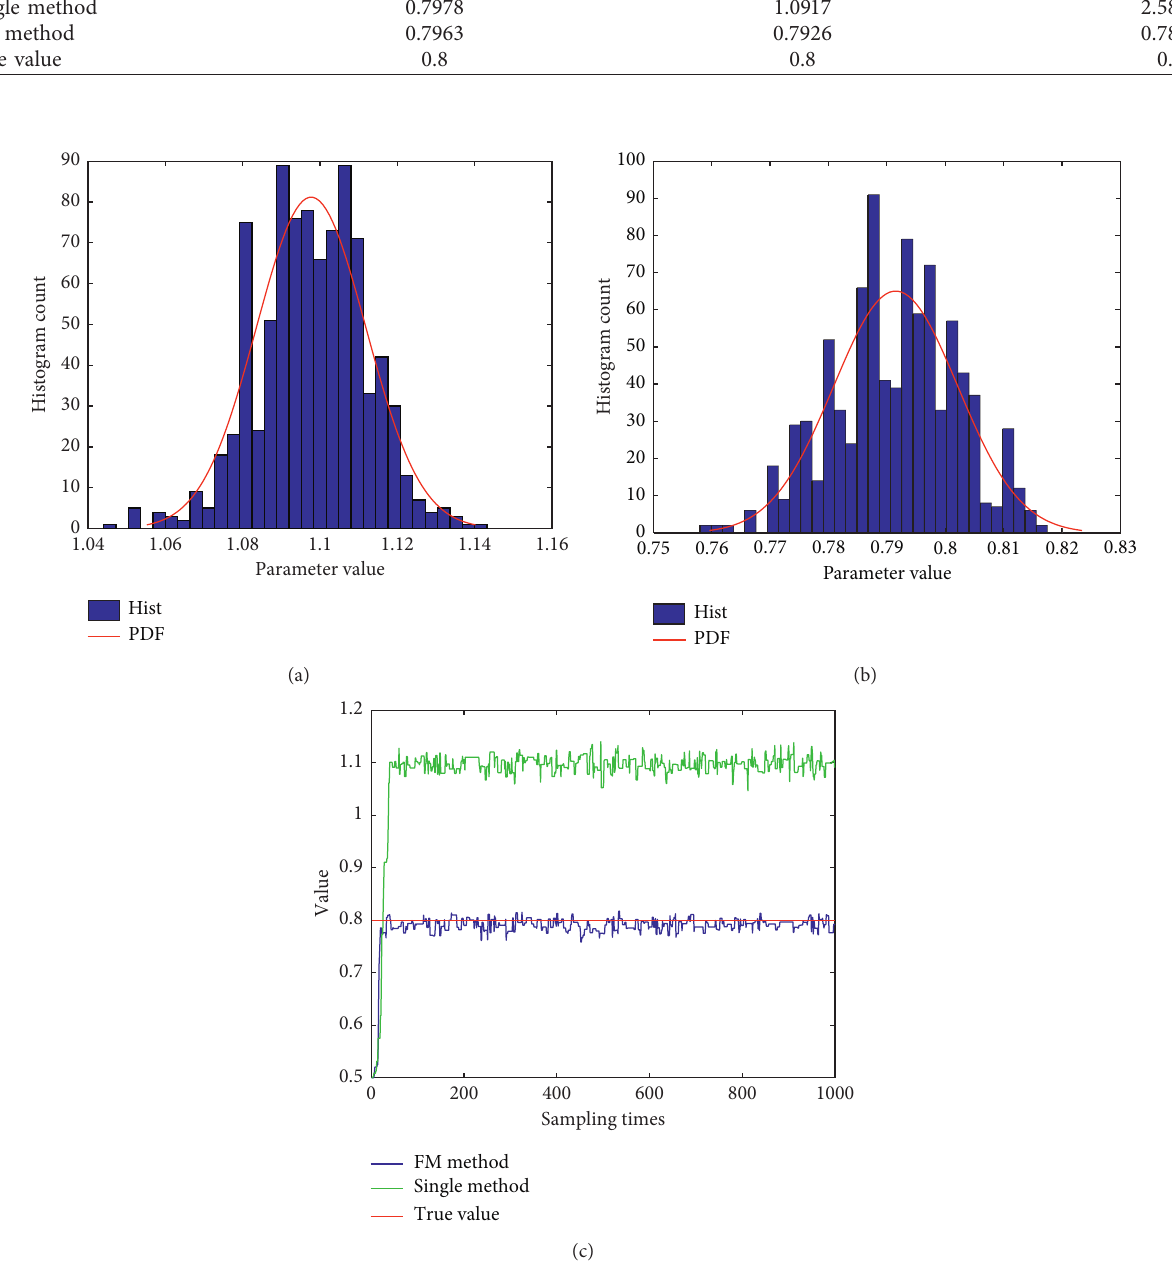
Figure 5: Case study 2: (a) single method, (b) FM method, and (c) sampling